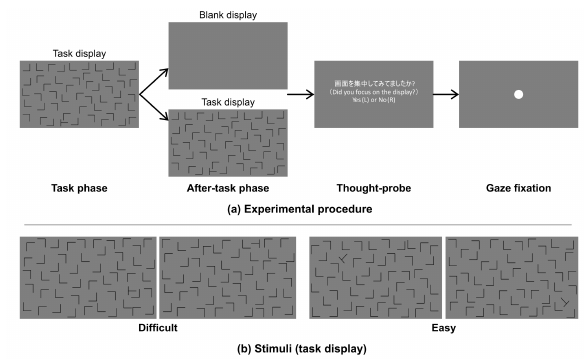
Figure-01 (a) Time schedule of stimulus presentation and (b) examples of visual search